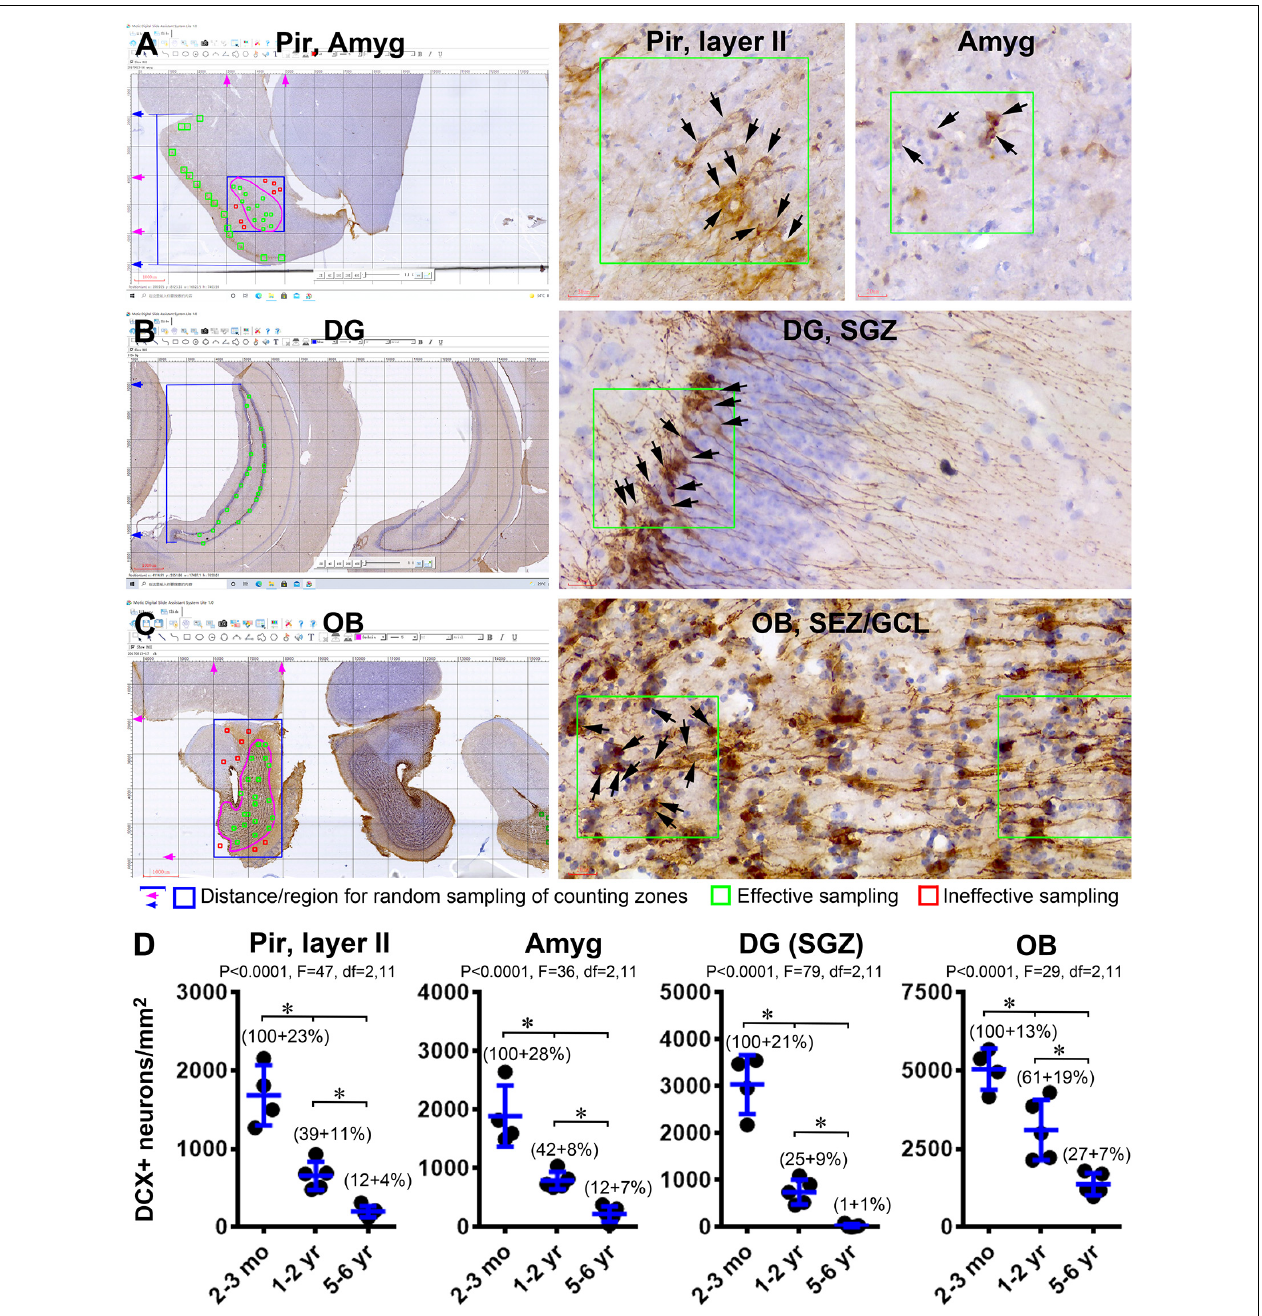
FIGURE 6 | Quantification of age-related decline of DCX+ immature neurons in the forebrain of Chinese tree shrews. Panels (A–C) illustrate the methodology for cell count in randomly determined zones in the piriform cortex (Pir) (A) , amygdala (Amyg) (A) , dentate gyrus (DG) (B) , and the olfactory bulb (C) . Counting zones (200 × 200 µ m 2 ) intersecting with layer II in the Pir are randomly generated based on the distance scales from the piriform sulcus to the ventral border of the cerebrum (marked with blue lines and arrows in A ). Counting zones (100 × 100 µ m 2 ) in the Amyg are randomly generated in a rectangular area (boxed with blue lines) covering the entire amygdalar complex (pink circle). Only the zones (marked in green) within this tear-drop-shaped nucleus are considered as effective samples, whereas the zones (marked in red) outside its anatomical border are considered as ineffective sampled sites. Similarly, the counting zones (100 × 100 µ m 2 ) intersecting with the subgranular zone (SGZ) in the DG are randomly generated based on the distance scales from dorsal and ventral edges of the granule cell layer (GCL) (B) . The effective sampling zones inside the bulb are across the granule cell layer (GCL) and the subependymal zone (SEZ) (pink circle), which are generated randomly within a rectangular area (marked with blue lines) covering the entire bulb. Panel (D) plots the means of DCX+ cell densities in the four regions from individual animals arranged in the three age groups ( n = 4 in the 2–3 mo-old group, n = 5 in 1–2 yr-old group, and n = 5 in the 5–6 yr-old group). The normalized means relative to the youngest group are also provided in the graphs. Statistical results and significant intergroup differences ( ∗ ) based on the one-way ANOVA test with Bonferroni’s pair-wise multiple comparisons are as indicated in individual graphs.